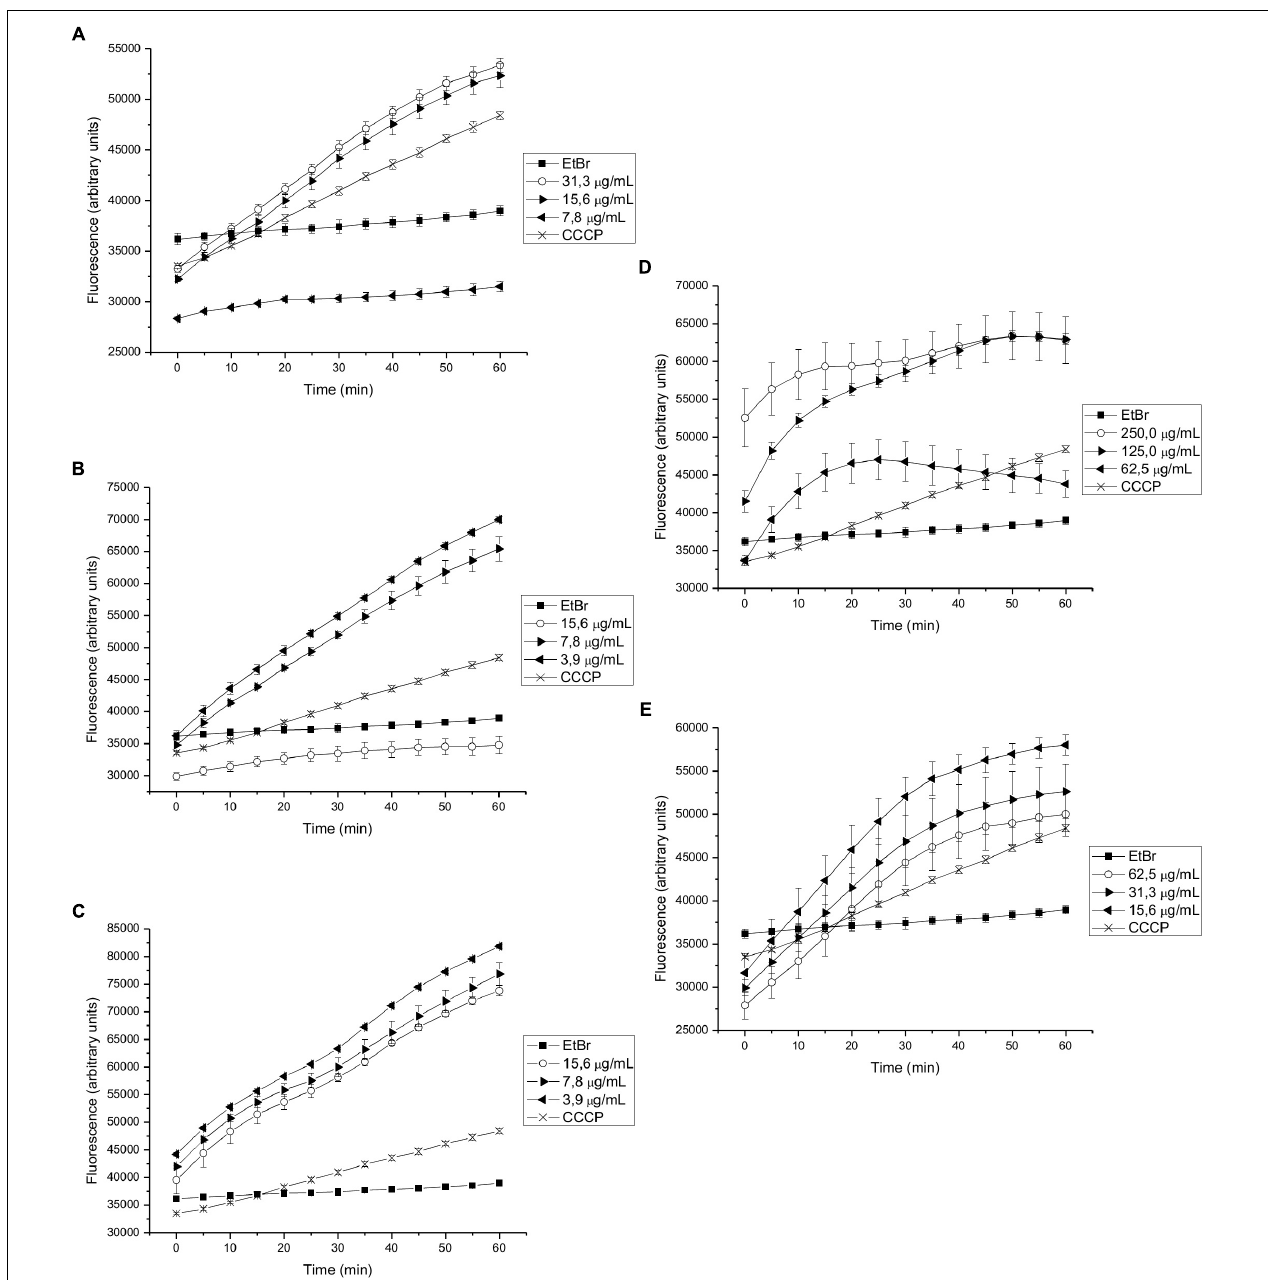
FIGURE 3 | Effect on the intracellular accumulation of ethidium bromide of (A) DCME extract, (B) epi -cubenol (4), (C) 15-copaenol (6), (D) 15-copaenal (6OX), and (E) 15-copaenyl acetate (6AC) in S. aureus wild-type (NCTC 8325-4). The bacteria were exposed to 2.0 µ g/mL of EtBr at 37 ◦ C for a period of 1 h in the presence of glucose. CCCP (1.25 µ g/mL) was used as inhibitor